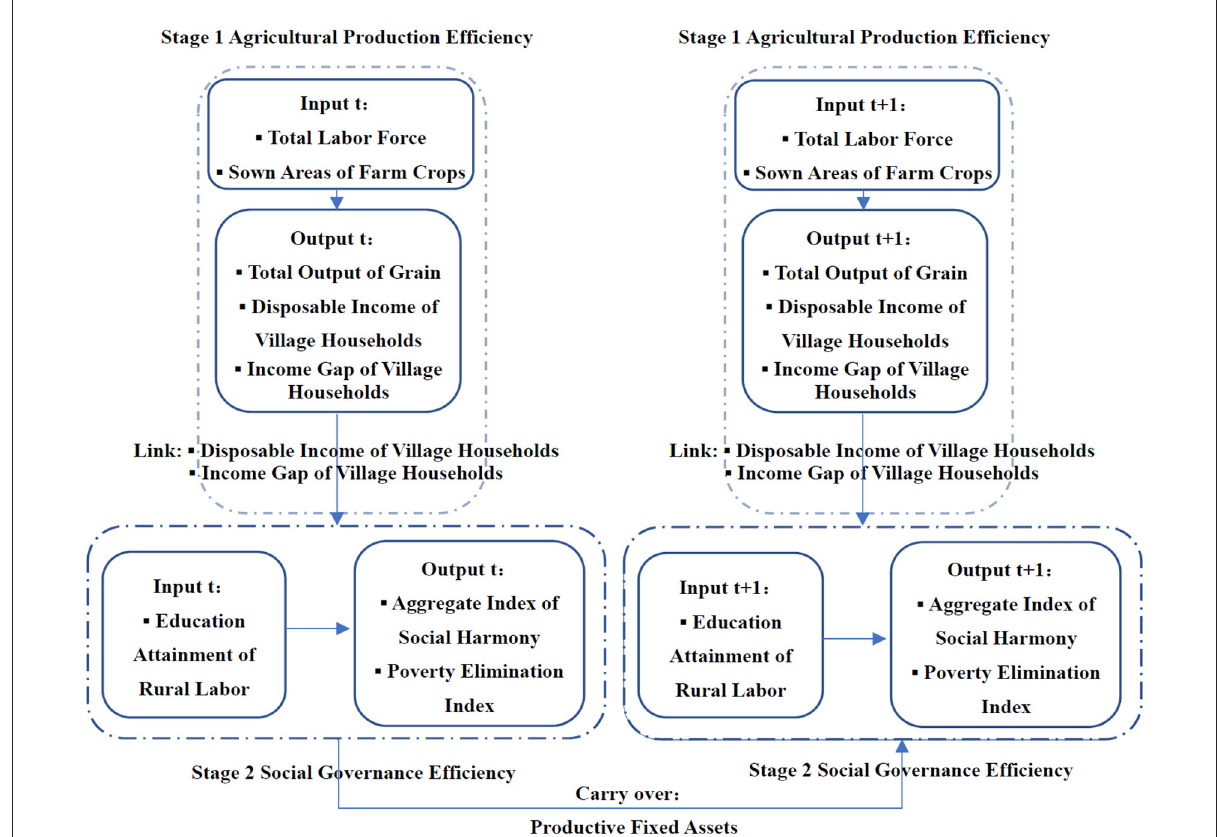
FIGURE2 Two-stage dynamic SBM-DEA model frameworks with consideration of undesirable